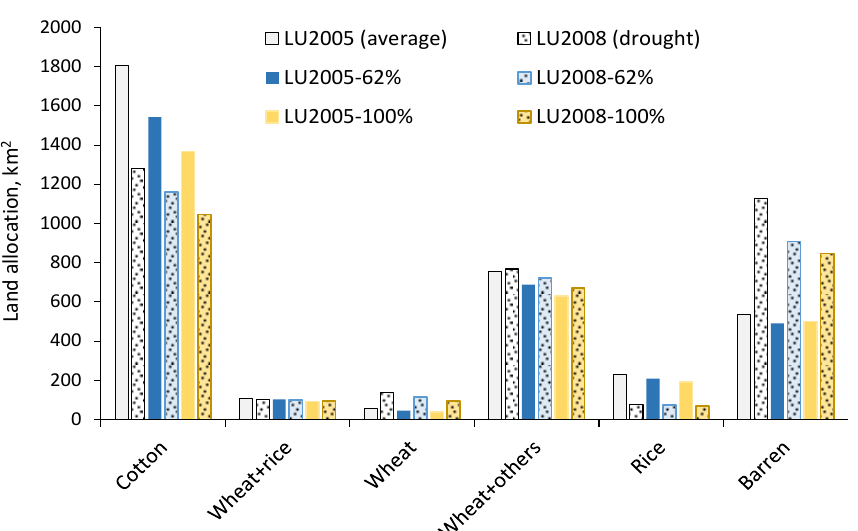
Figure 8. Shares of land use classes in the Khorezm region (Uzbekistan) in 2005 representing average climate conditions (LU2005), the 62% afforestation scenario (LU2005-62%), and the 100% afforestation scenario (LU2005-100%), land use in 2008 representing drought conditions (LU2008), the 62% afforestation scenario (LU2008-62%), and the 100% afforestation scenario (LU2008-100%).